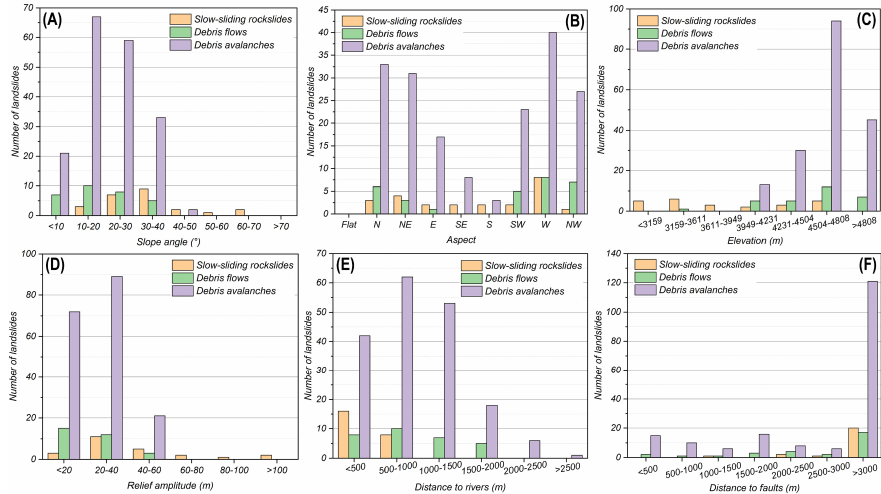
Figure 12. The relationship between landslide distribution and controlling factors: ( A ) slope angle, ( B ) aspect, ( C ) elevation, ( D ) relief amplitude, ( E ) distance to rivers, and ( F ) distance to